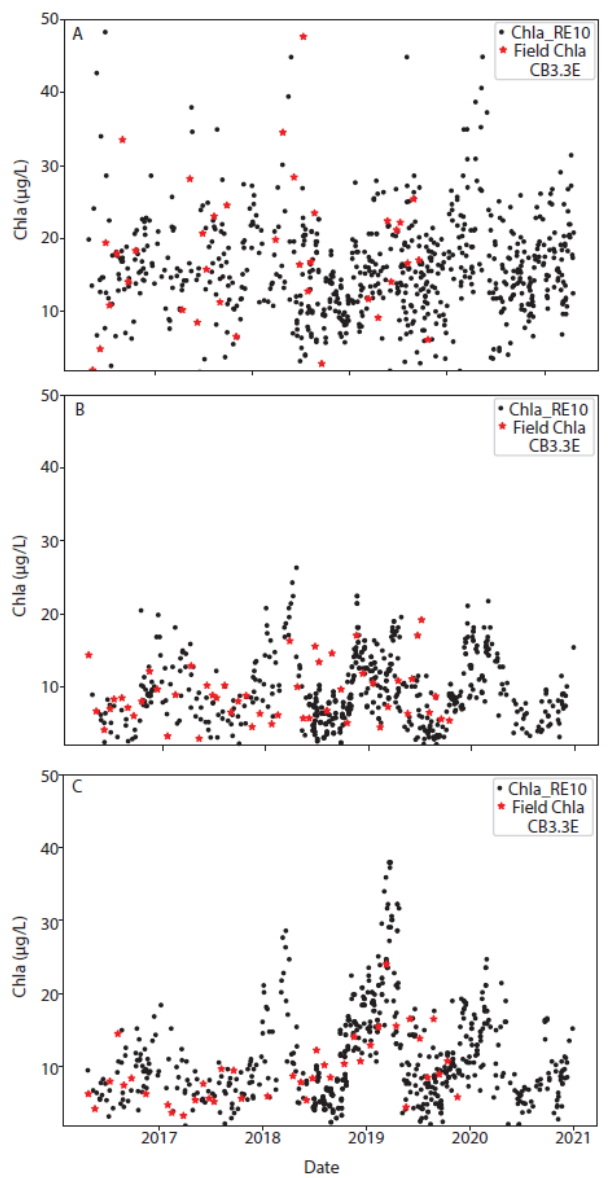
Figure 11. Time series of the RE10 chla algorithm (black dots) along with any available field data (red stars) for three selected stations: one in the ( A ) upper bay (station 3.3 E), ( B ) middle bay (Station 5.2), and ( C ) lower bay (station 7.1 N). This climatology was calculated using the mean of all data from the start of the Sentinel-3A mission (February 2016) through October 2021. Additional time series graphs for other stations are available in the Supplementary